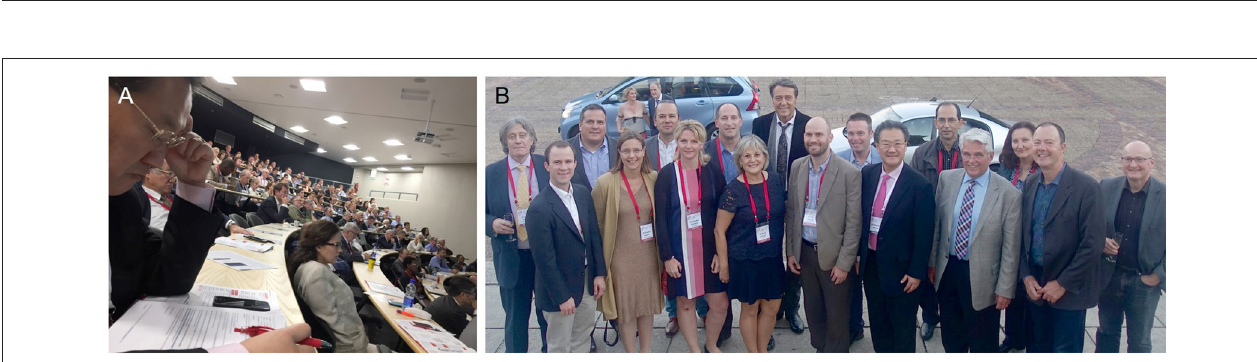
FIGURE 2 | (A) ISACB Meeting in 2017 took place as part of the 50th Anniversary Heart Transplant Celebration in Cape Town, “Courage and Innovation: 50 Years of transplantation” at Groote Schuur Hospital. (B) ISACB members at the reception of the 50th Anniversary Heart Transplant Celebration in Cape Town, “Courage and Innovation: 50 Years of transplantation”.